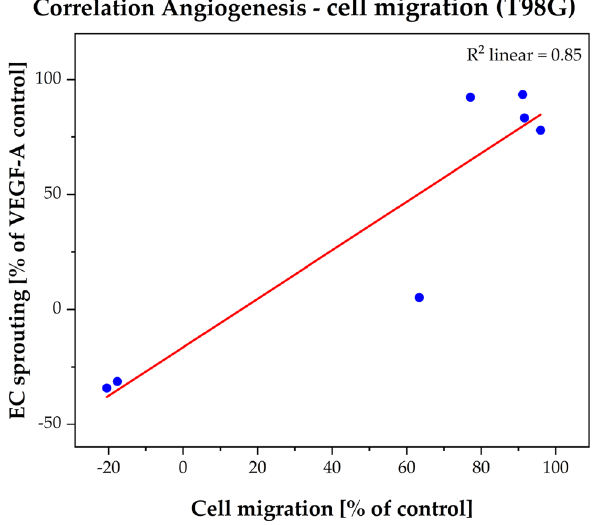
Fig. 7 Correlation between angiogenesis and cell migra- tion by the cell line T98G. The red curves represent the linear regression analysis for the Ouabain concentration (10 –12 to 10 –5 M) with the coefficient of determination (R 2 = 0.85) based on Pearson